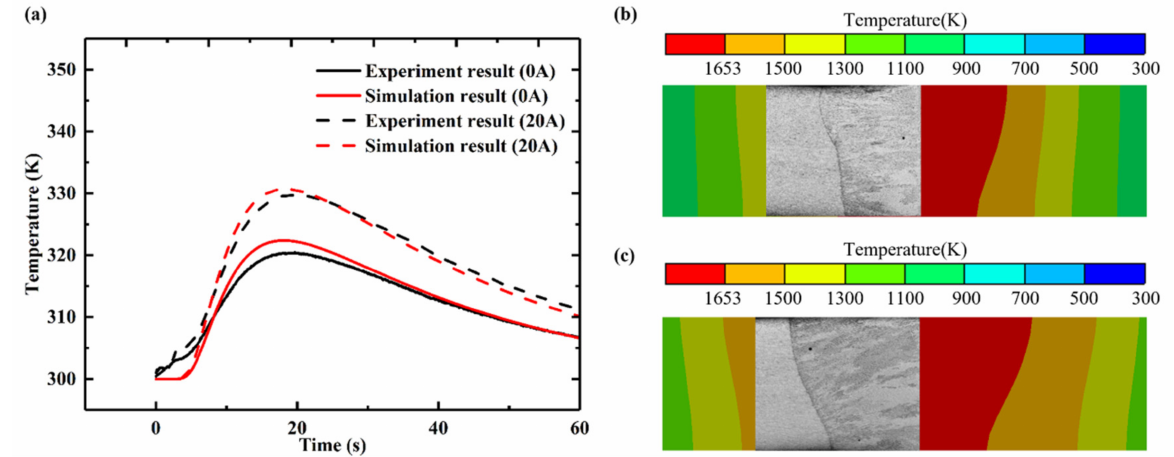
Figure 7. Comparison of experimental temperature verification. ( a ) Temperature curve at point A (30,30,1). ( b ) Comparison of cross-section molten pool morphology with a 0 A current. ( c ) Comparison of cross-section molten pool morphology with a 20 A current.